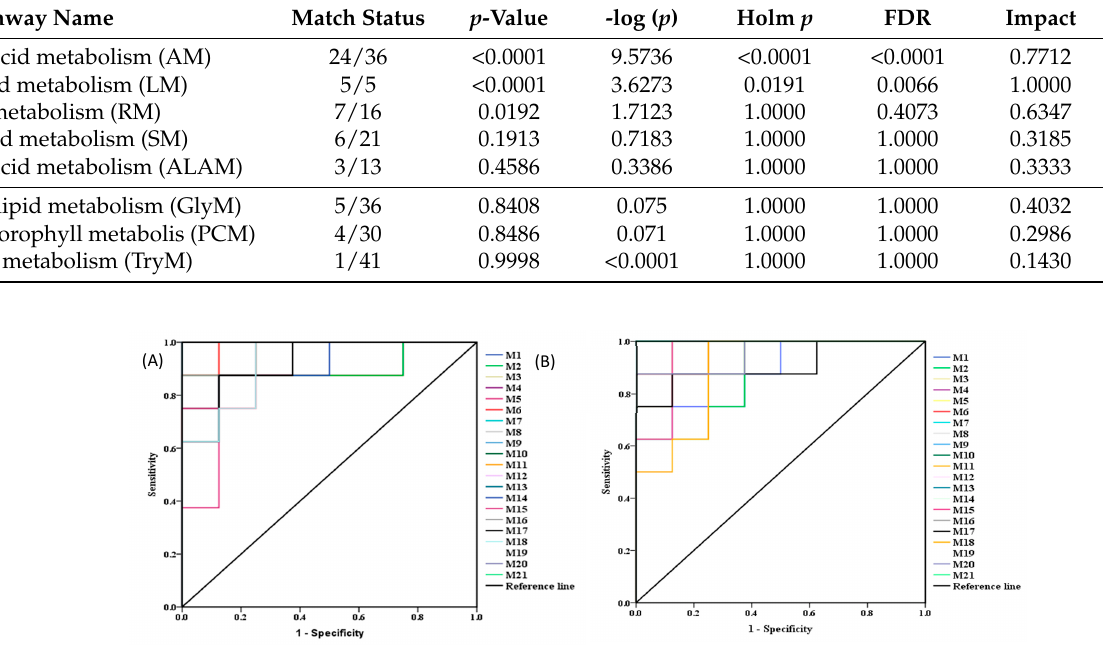
Figure 8. The predictive receiver operating characteristic (ROC) curves generated using 21 biomarkers contributing to ( A ) liver ‐ tumor progress between model group and normal group, ( B ) compound 2e treatment between model group and compound 2e group. Table 8. The area under curve (AUC) values and p -values of the biomarkers in two predictive ROC